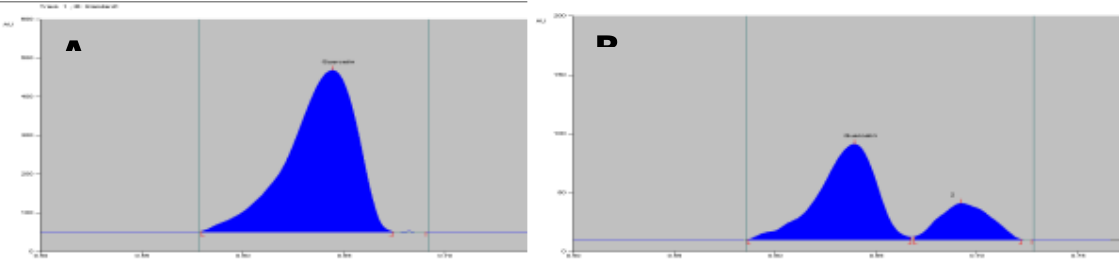
Figure 9. Chromatogram of quercetin in the standard solution (A) and the sample solution (B) According to the table obtained from the TLC scanner: AUC 1 = 4428.39, AUC 2 = 16554.55 and C 1 = 40 mg/L, C 2 = 5000 mg/L. Then, quercetin percentage was: 0.214 % of dried ethanolic extract of leaves and 0.024% of dried